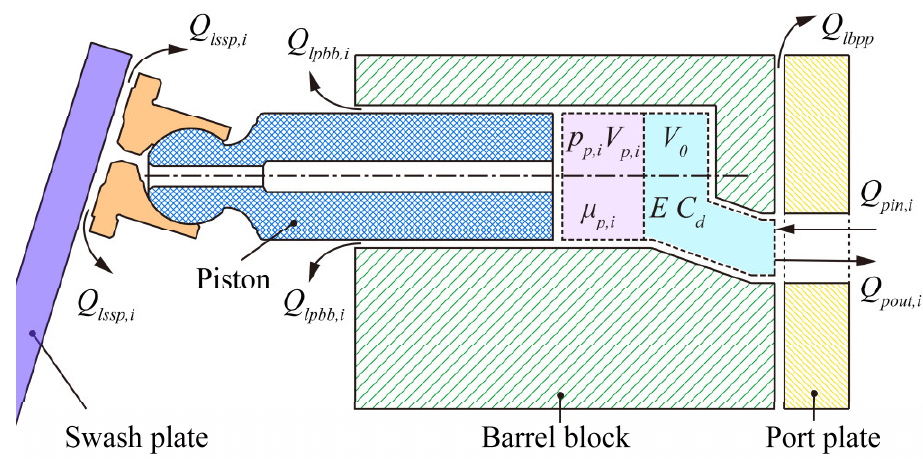
Figure 4. Model of the piston chamber.